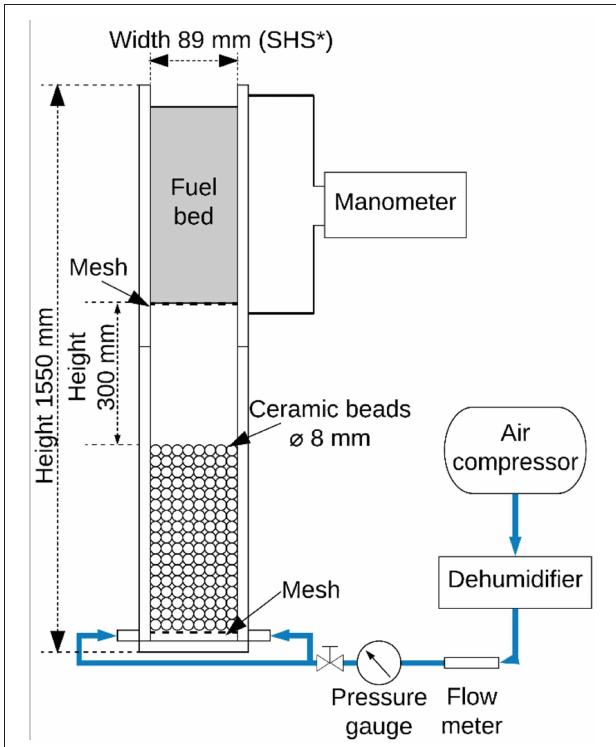
FIGURE 1 | Schematic diagram of the experimental testing apparatus for the air permeability experiments (SHS, Square hollow section; Fuel bed depth varies from 50 to